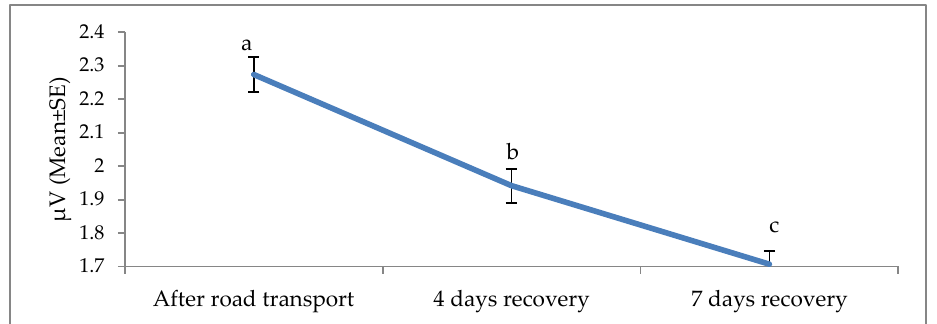
Figure 5. Effects of road transport on the beta root mean square (RMS) in cattle. The number of animals used in each sampling point was 24 heifers. Means with different letters are significantly different at p < 0.05.